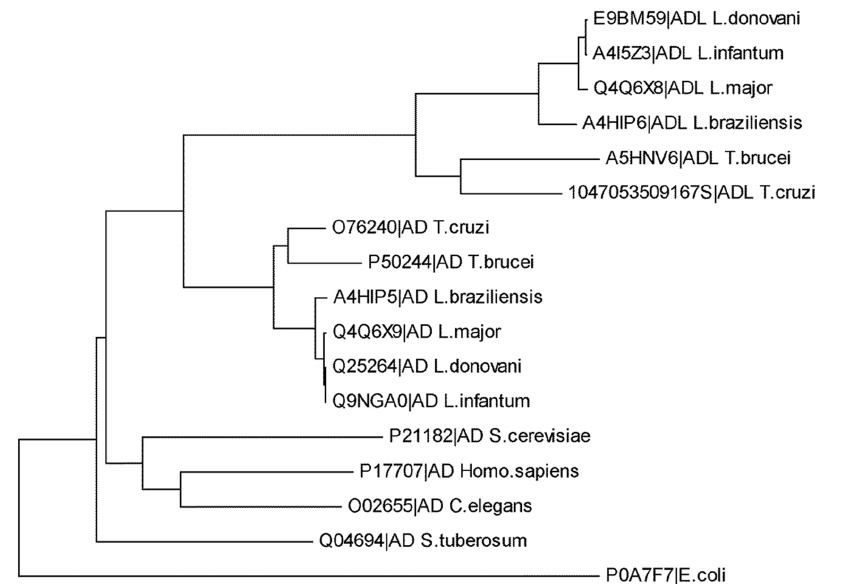
Figure 1. Phylogenetic analysis showing evolutionary patterns of AD and ADL in trypanosomatids. Amino acid sequences were retrieved from the Swiss-Prot gene data base and phylogenetic tree was constructed using MEGA 5.0 software showing the different clusters of AD and ADL.